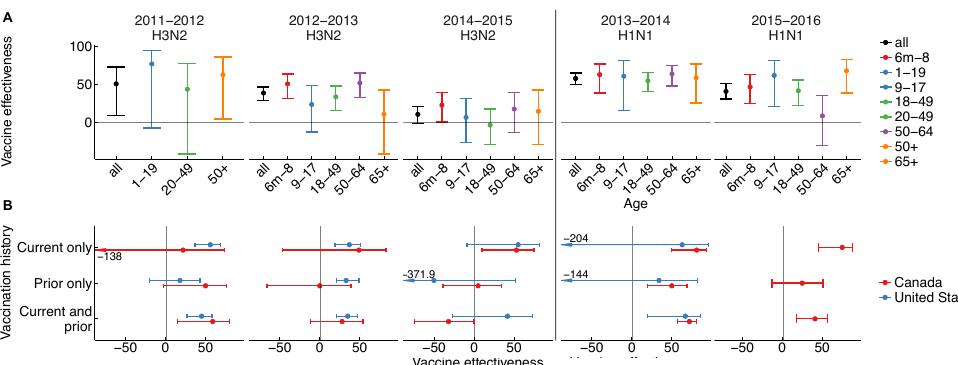
Figure 1. Vaccine effectiveness from the U.S. and Canada ( A ) overall and by age group and ( B ) by recent vaccination history. Comparisons must be made with caution due to differences in study design and study population. Please see Table A1 in the Appendix A for